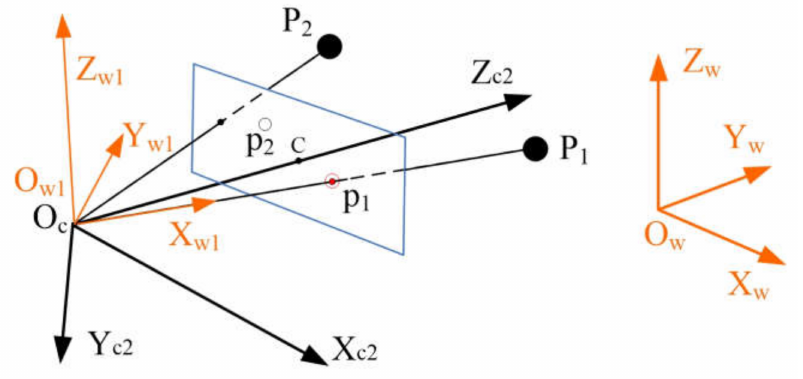
Figure 5. New world frame O_ZYZ_w 1. The Xw 1 -axis is collinear with the line OcP 1 .